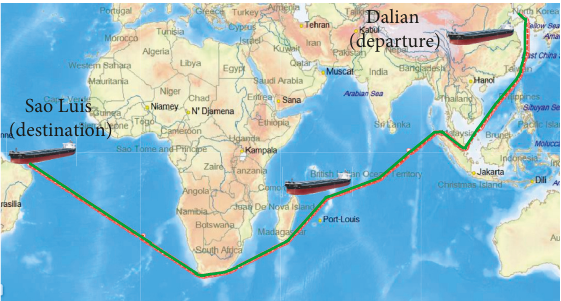
Figure 1: Sailing route of the ship.